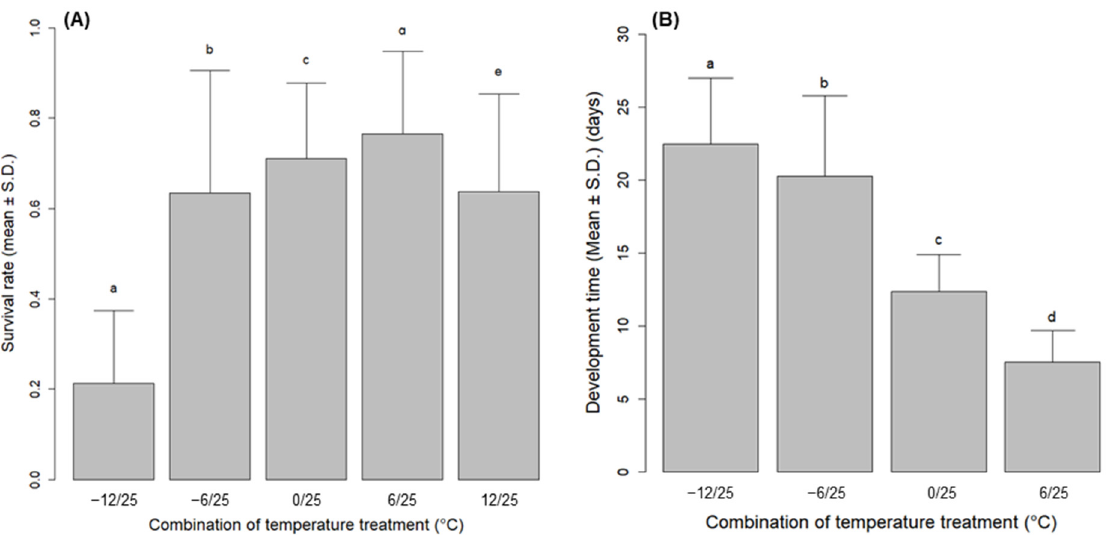
Figure 3. ( A ) survival rate and ( B ) development time of Lymantria dispar asiatica eggs of eight experimental populations for each treatment. Different letters above the bars indicate significant differences according to mixed effect models ( p < 0.001). Table 2. Summary of survival rate and development time of Lymantria dispar asiatica eggs depending on exposure to chilling temperatures for 100 days, followed by 25 °C incubation.